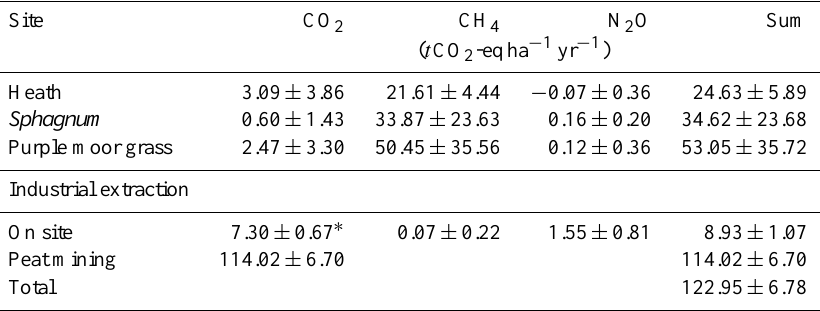
Table 4. Greenhouse gas (GHG) budgets of four bog sites. The GHG budget of the active industrial extraction site is composed of measured fluxes on site and the C loss due to peat mining in 2011, assuming its emission as CO 2 . Values represent means of four (CO 2 and CH 4 ) or three (N 2 O) replicates ±